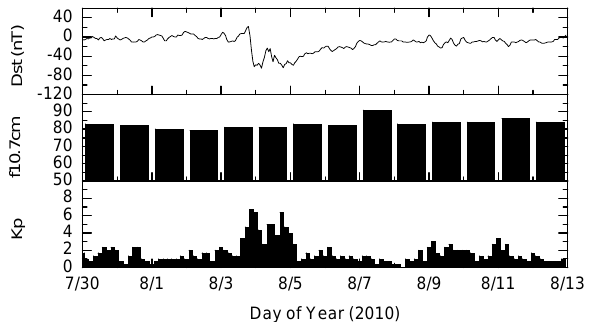
Fig. 9. Dst, F 10 . 7 , and K p indices during 30 July 2010 to 12 Au- gust 2010.